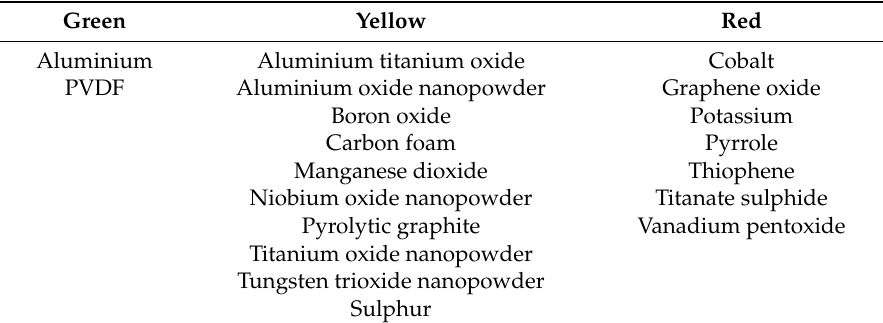
Table A1. Exposure risks and hazards rating of